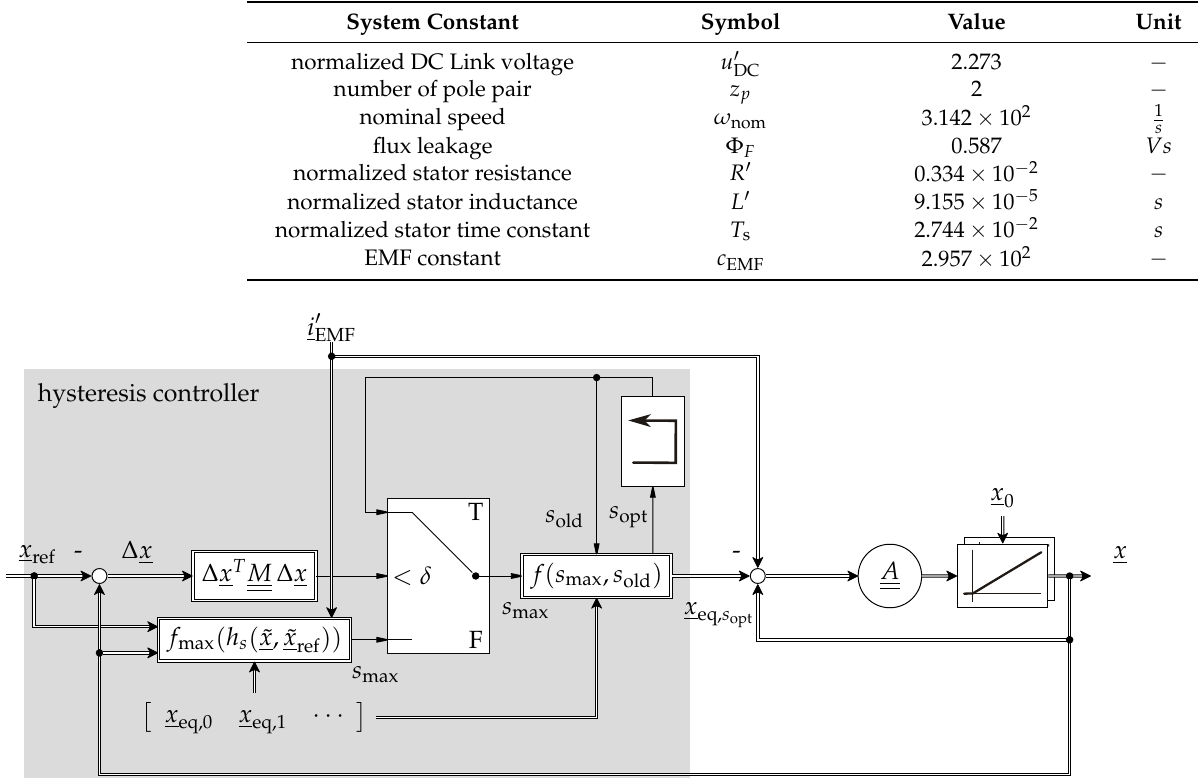
Figure 11. Implemented simulation